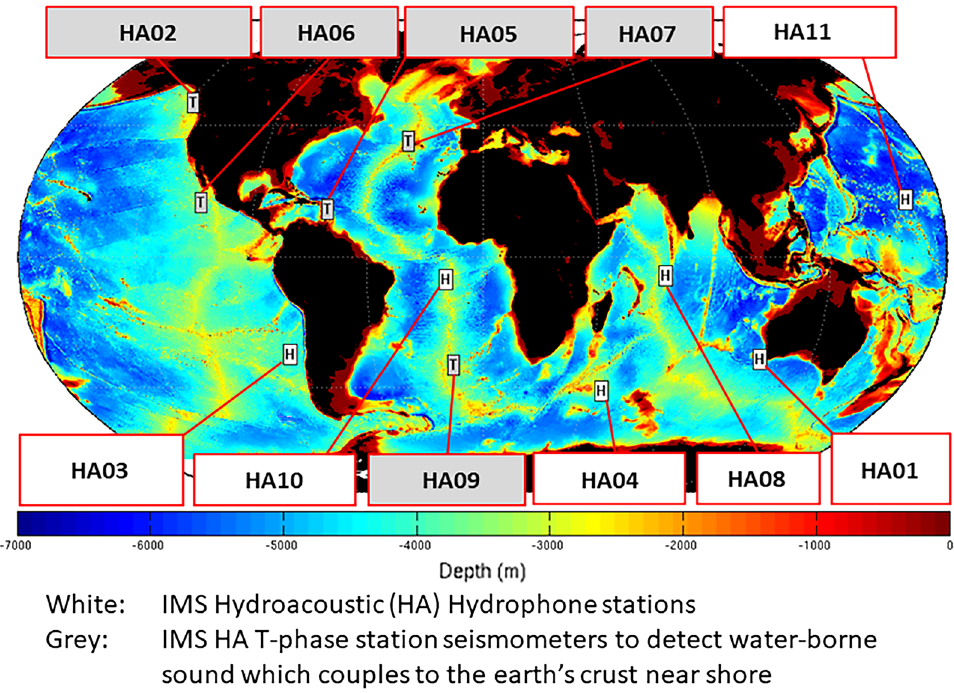
Figure 1. Locations around the globe of the eleven hydroacoustic stations of the CTBT IMS comprising six hydrophone stations (labelled in white) and five seismic T-phase stations (labelled in grey). The hydrophone stations considered in this study are Wake Island (HA11) located in the Western Pacific Ocean, Ascension Island (HA10) located in the South Atlantic Ocean, Diego Garcia Island located in the Indian Ocean (HA08), Juan Fernandez Islands located in the South Pacific Ocean (H03N), and Cape Leeuwin (H01W) located off the southwest shore of Western Australia. (Courtesy of CTBTO—reproduced by